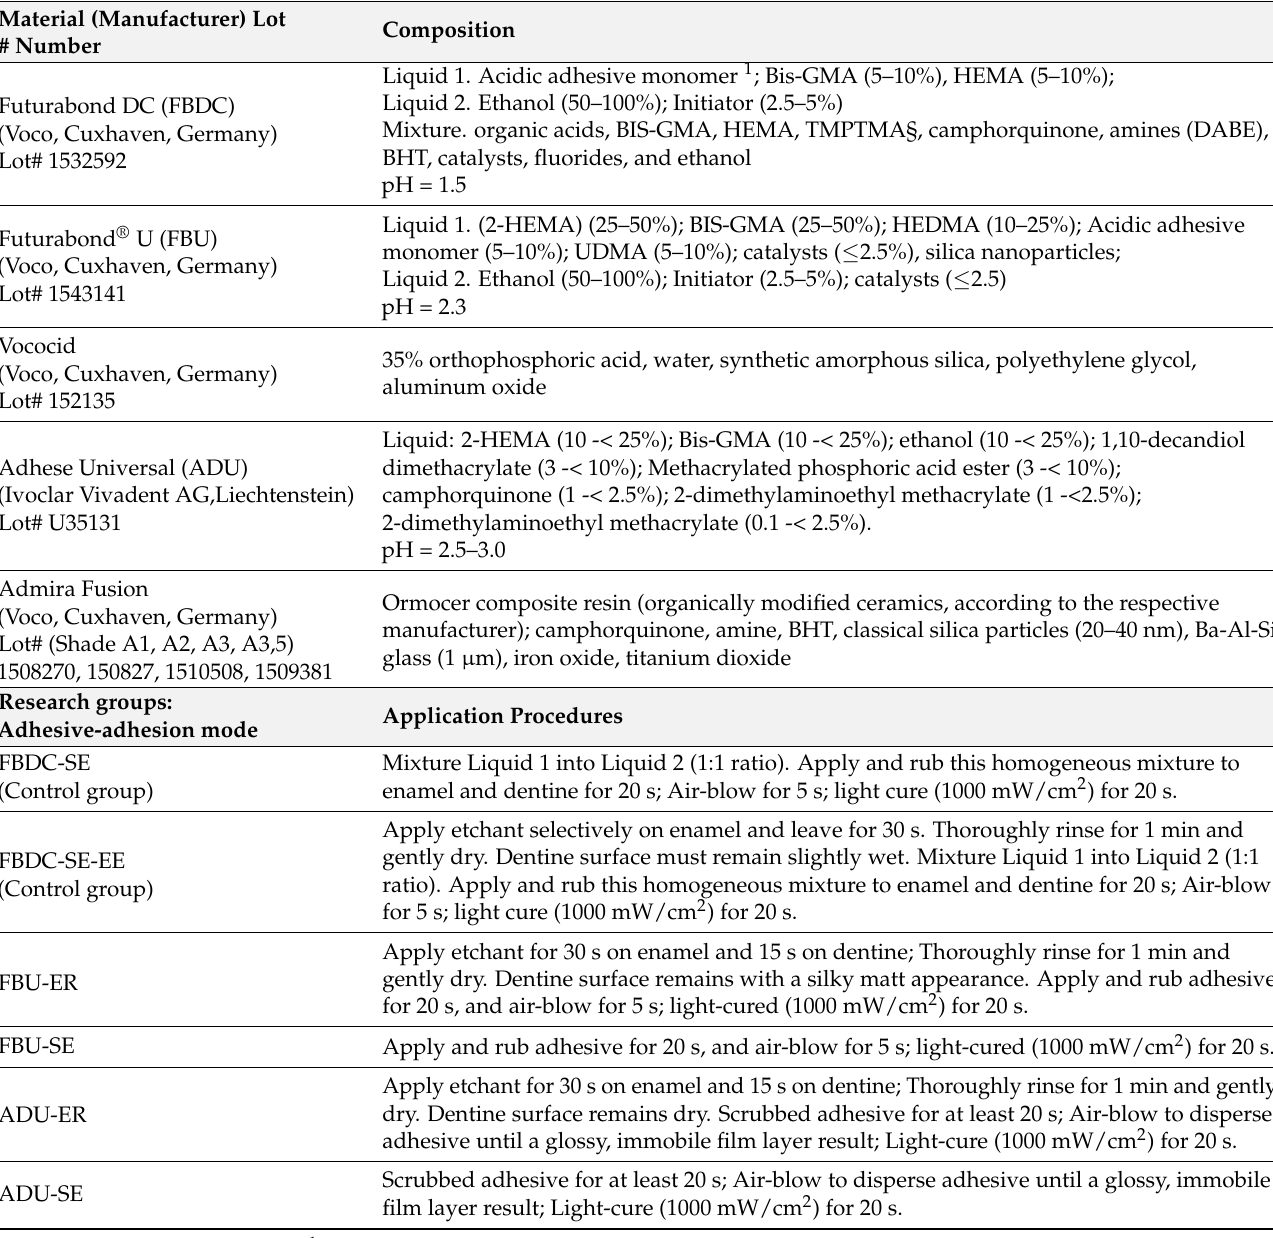
Table 1. Details of the materials used in each research group and their application